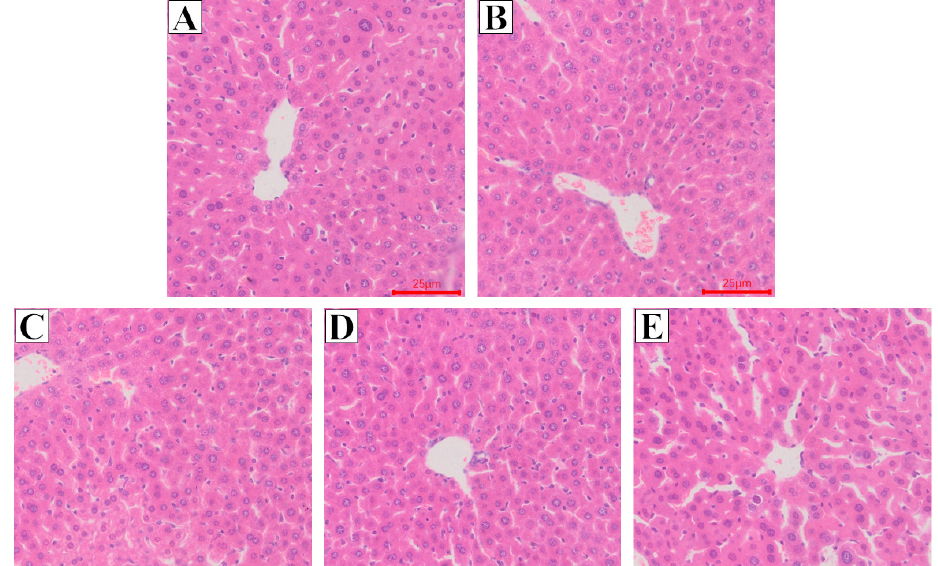
Figure 2. Effect of Glycine nano-selenium on pathological changes of liver tissue( A – E , 400×). We observed that the liver tissue structure of mice in each group was complete, the hepatic cord was in a cord shape, the outline of hepatocytes was clear, and there were no obvious pathological changes (n = 5). Control, received no immunization + 0.5 mL normal saline; positive, received H9N2 AIV vaccine + 0.5 mL 0.9% normal saline; 0.25 mg/kg group, received H9N2 AIV vaccine + 0.5 mL 0.25 mg/kg selenium solution; 0.5 mg/kg group, received H9N2 AIV vaccine + 0.5 mL 0.5 mg/kg selenium solution; 1 mg/kg group, received H9N2 AIV vaccine + 0.5 mL 1 mg/kg selenium